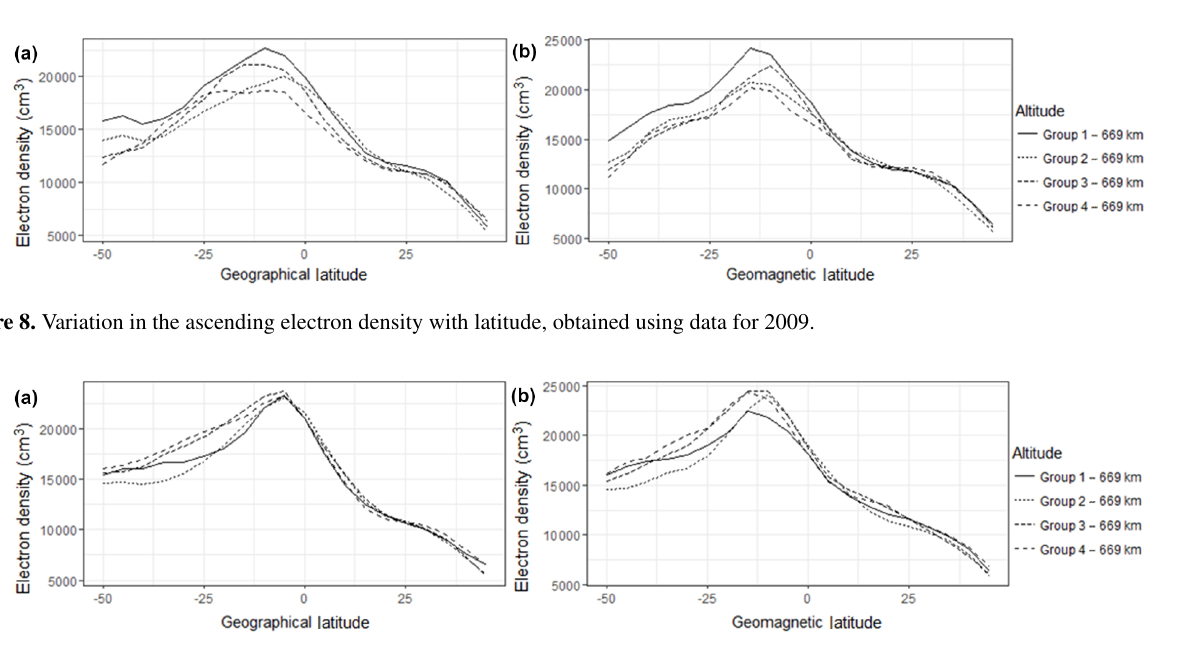
Figure 9. Variation in the ascending electron density with latitude, obtained using data for